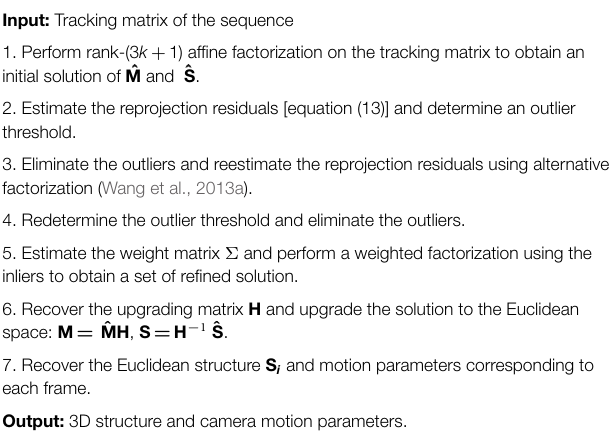
ALGORITHM 1 | Robust non-rigid factorization